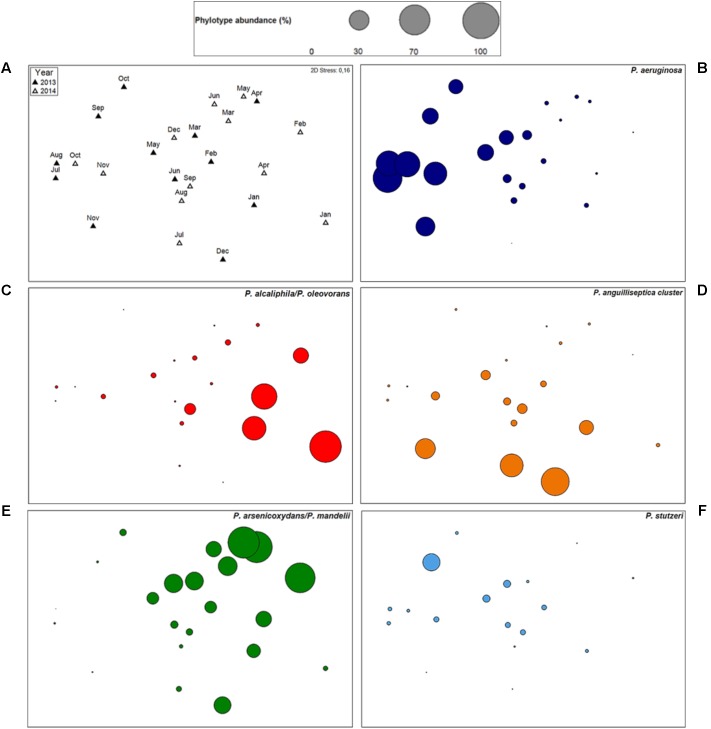
Pseudomonas community structure and dynamics of individual phylotypes. Non-metric multidimensional scaling (nMDS) plot (A) comparing the Pseudomonas community structure of cooling tower water samples, sampled from January 2013 to December 2014. Phylotypes standardized untransformed data was used for calculation of Bray–Curtis similarity. Filled and empty triangles represent 2013 samples and 2014 samples, respectively. Kruskal 2D Stress: 0.16. (B–F) Individual bubble plots for five phylotypes [P. aeruginosa
(B), P. alcaliphila/P. oleovorans
(C), P. anguilliseptica cluster (D), P. arsenicoxydans/P. mandelii
(E), and P. stutzeri
(F)], on the same nMDS, with absence of dot representing no detection of the phylotype and circle sizes proportional to untransformed relative abundance. P. anguilliseptica cluster includes species P. anguilliseptica, P. peli, and P. guineae. The scale is common to all plots.